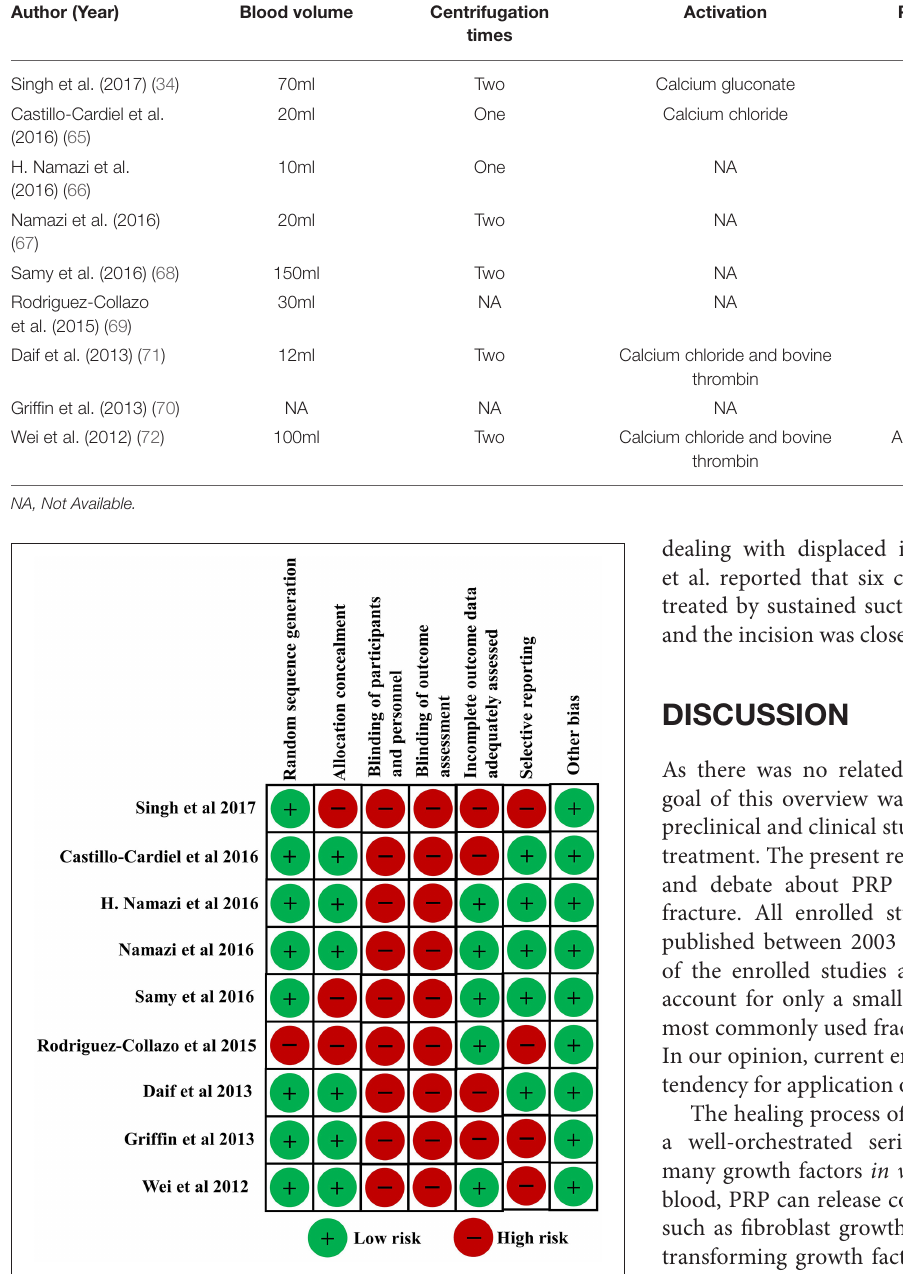
FIGURE 4 | Risk of bias of all enrolled clinical